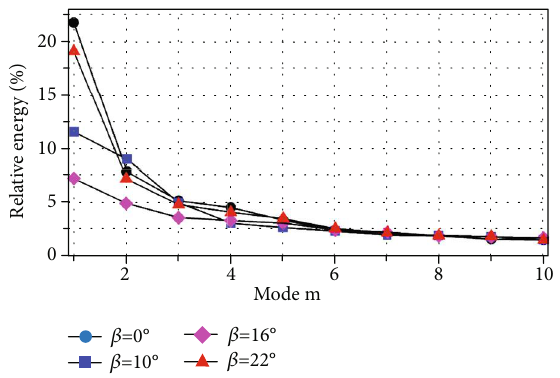
Figure 15: Relative energy of the fi rst 10 POD